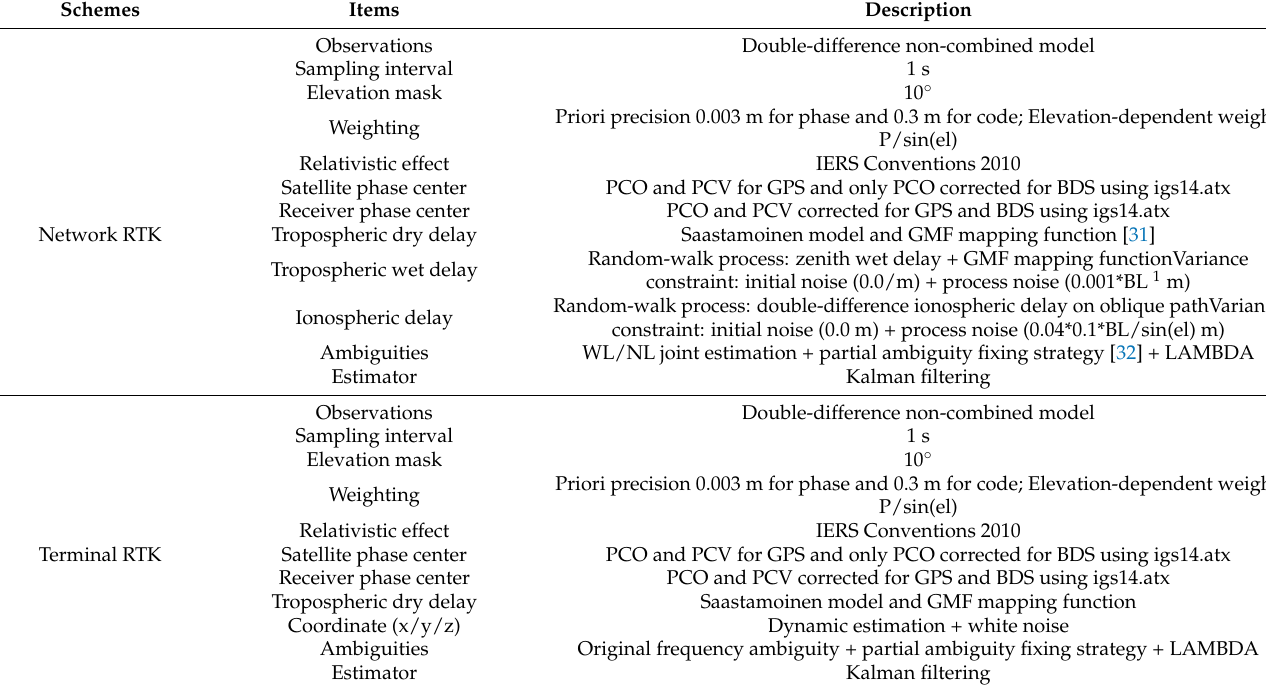
Table 2. Data processing strategy of network RTK and terminal